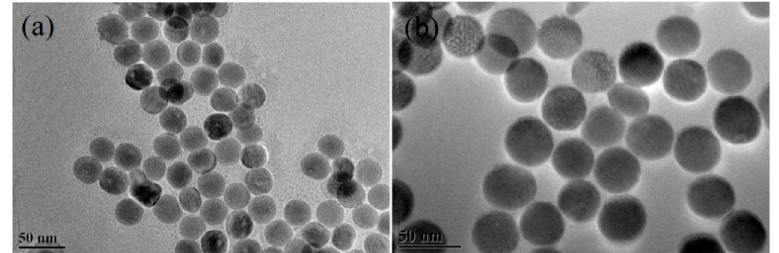
Figure 2. TEM pictures of ( a ) NaYF 4 :Yb 3+ /Er 3+ and ( b ) NaYF 4 :Yb 3+ /Er 3+ @NaYF 4 :Yb 3+ nanocrystals.